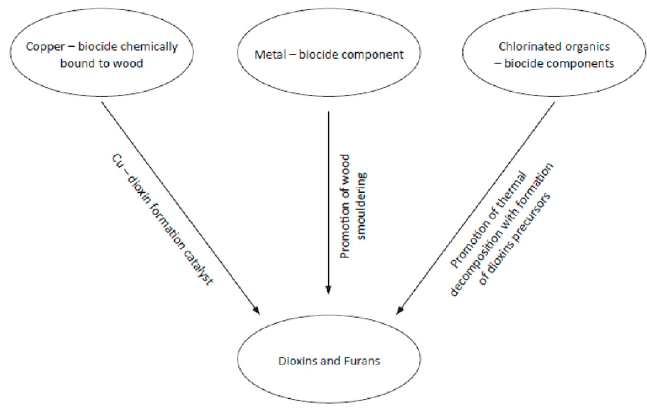
Figure 1. The effect of impregnates chemistry on dioxins and furans emissions. Figure 1. The e ff ect of impregnates chemistry on dioxins and furans emissions.